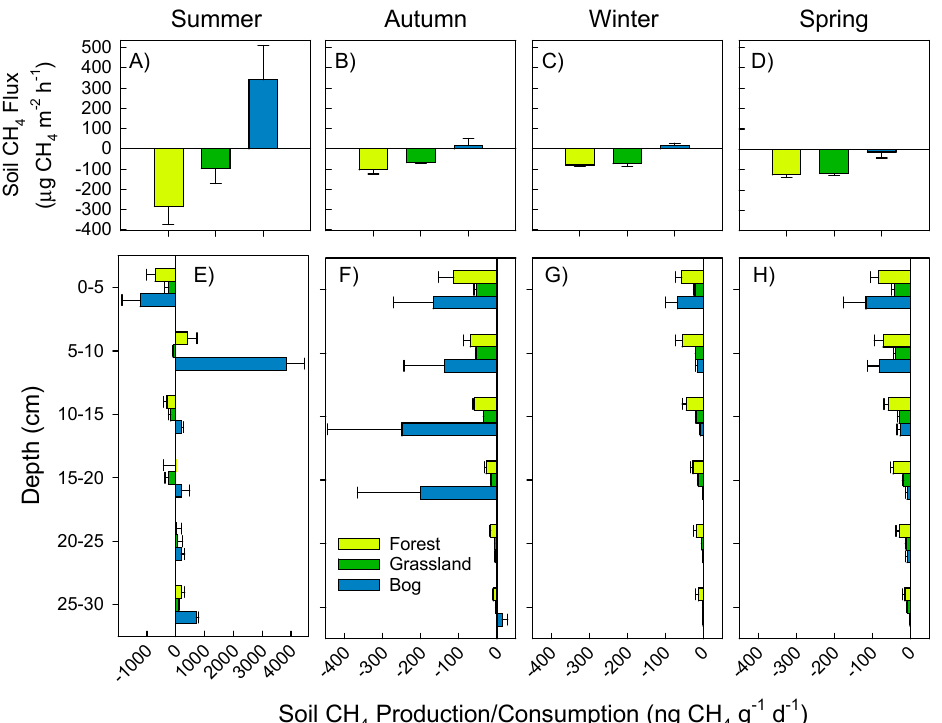
Figure 3. Soil CH 4 fluxes (top panels, A – D ) and production/consumption (bottom panels, E – H ). Surface flux measurements and soils collected for production on 17 February (summer, A , E ), 25 May (autumn, B , F ), 22 September (winter, C , G ), and 23 November (spring, D , H ) in 2015. Mean and standard error shown ( n = 4). Table 1. Annual estimates (mean, standard error, and range) for net ecosystem flux of CO 2 and CH 4 .